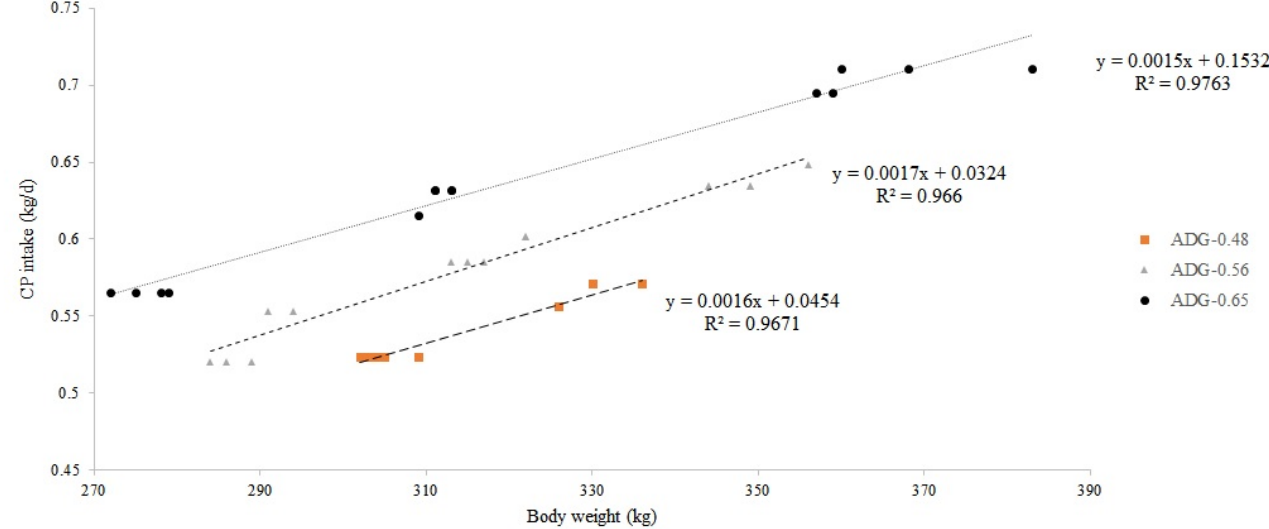
Figure 3. Regression equation for calculation of crude protein (CP) requirements (kg/d) of Hanwoo heifers. ADG, average daily gain. ADG-0.48, y = 0.0016x+0.0454 (R 2 = 0.9671), ADG-0.56, y = 0.0017x+0.0324 (R 2 = 0.9660); ADG-0.65, y = 0.0015x+0.1532 (R 2 = 0.9763).